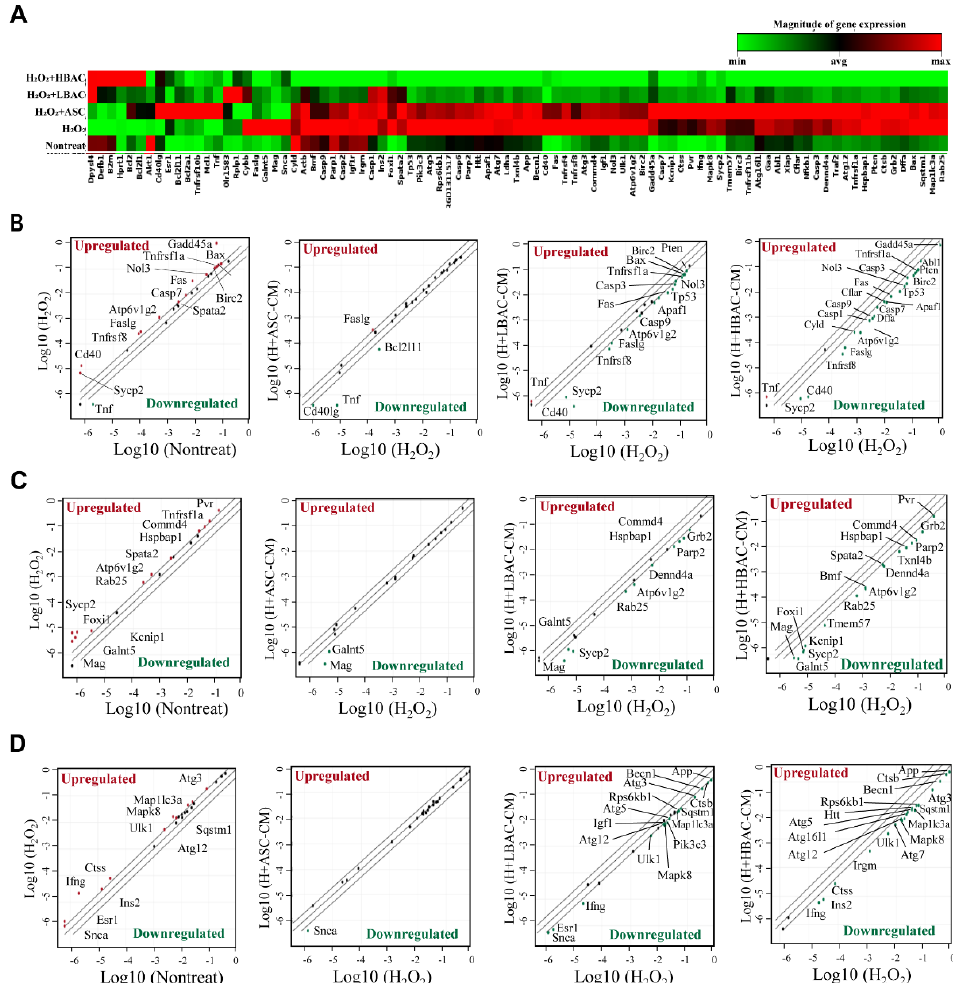
Figure 4. Regulation of multiple cell death signals by beige adipocyte secretions under oxidative stress. ( A ) Hierarchical cluster map of gene expression determined by PCR array. ( B ) Apoptosis signals. ( C ) Necroptosis signals. ( D ) Autophagy signals. The relative expression levels of each gene are plotted for each group comparison (nontreated vs. H 2 O 2 -stimulated sample, H 2 O 2 -stimulated sample vs. CM-treated sample). The diagonals show the same representation in both groups with a 2-fold change boundary. Upregulated genes with greater than 2-fold changes are marked above the middle line, and downregulated genes are marked below the line in each graph.